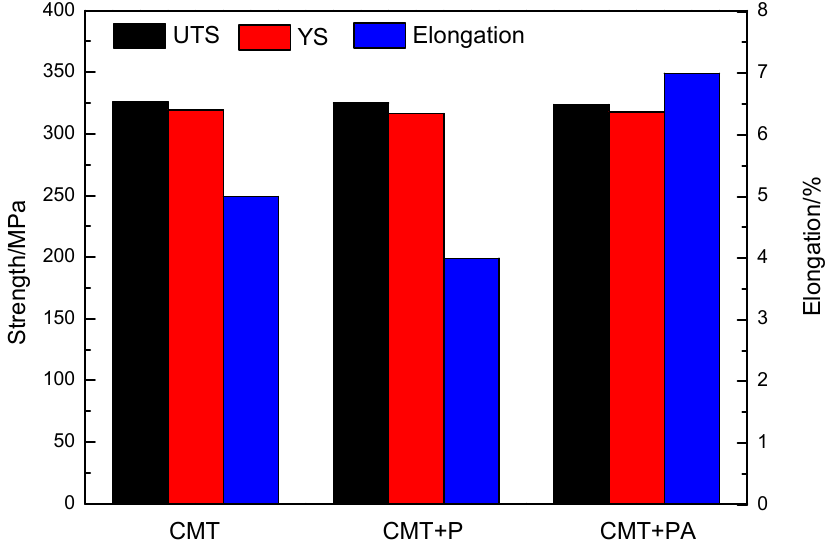
Figure 10. High-temperature mechanical properties of ZCL205A alloy deposited using different deposition processes.